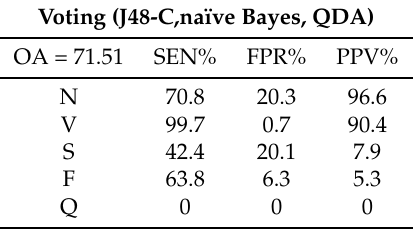
Table 13. Performance measures for combining J48-C, naïve Bayes, and QDA classifiers using a Voting scheme.